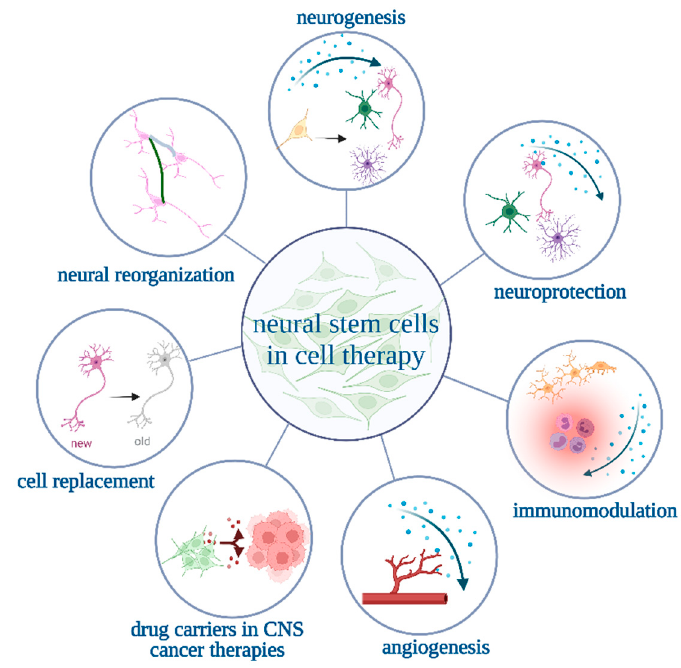
Figure 1. Possible benefits of neural stem cells’ (NSCs) use in clinical trials suggest the need to conduct further NSC studies at the preclinical level.